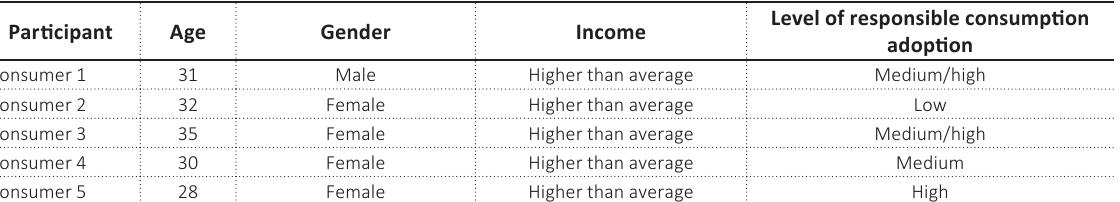
Table B1. Overview of consumers participated in the